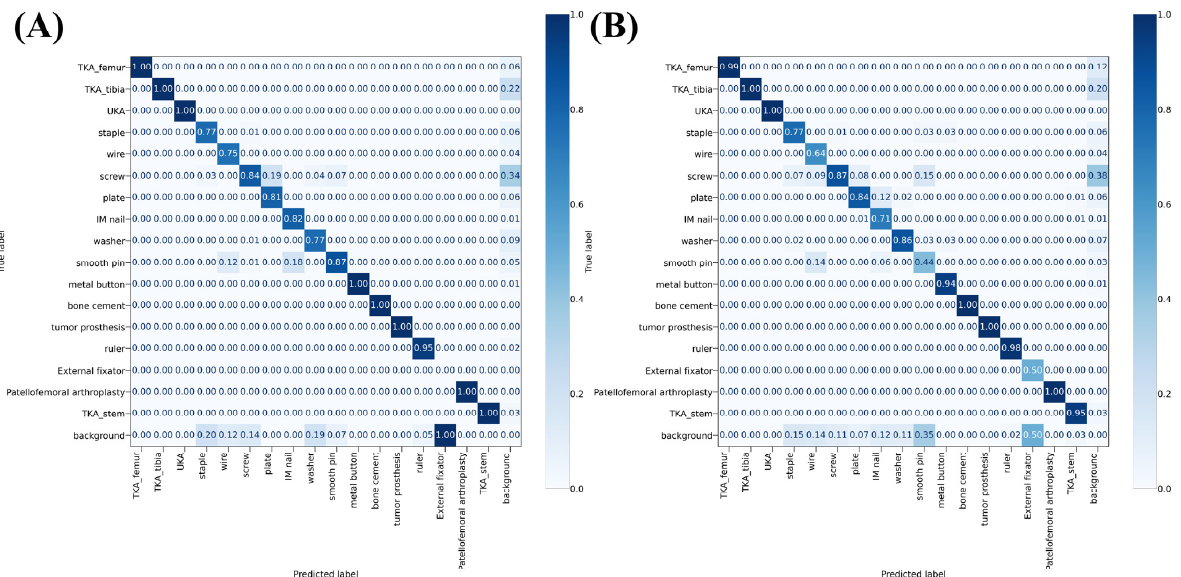
Figure 3. Confusion matrices on validation set ( A ), internal test set ( B ), and external test set ( C ). Among 18 labels on each axis, only ‘background’ is not an object class. If the ‘True label’ is